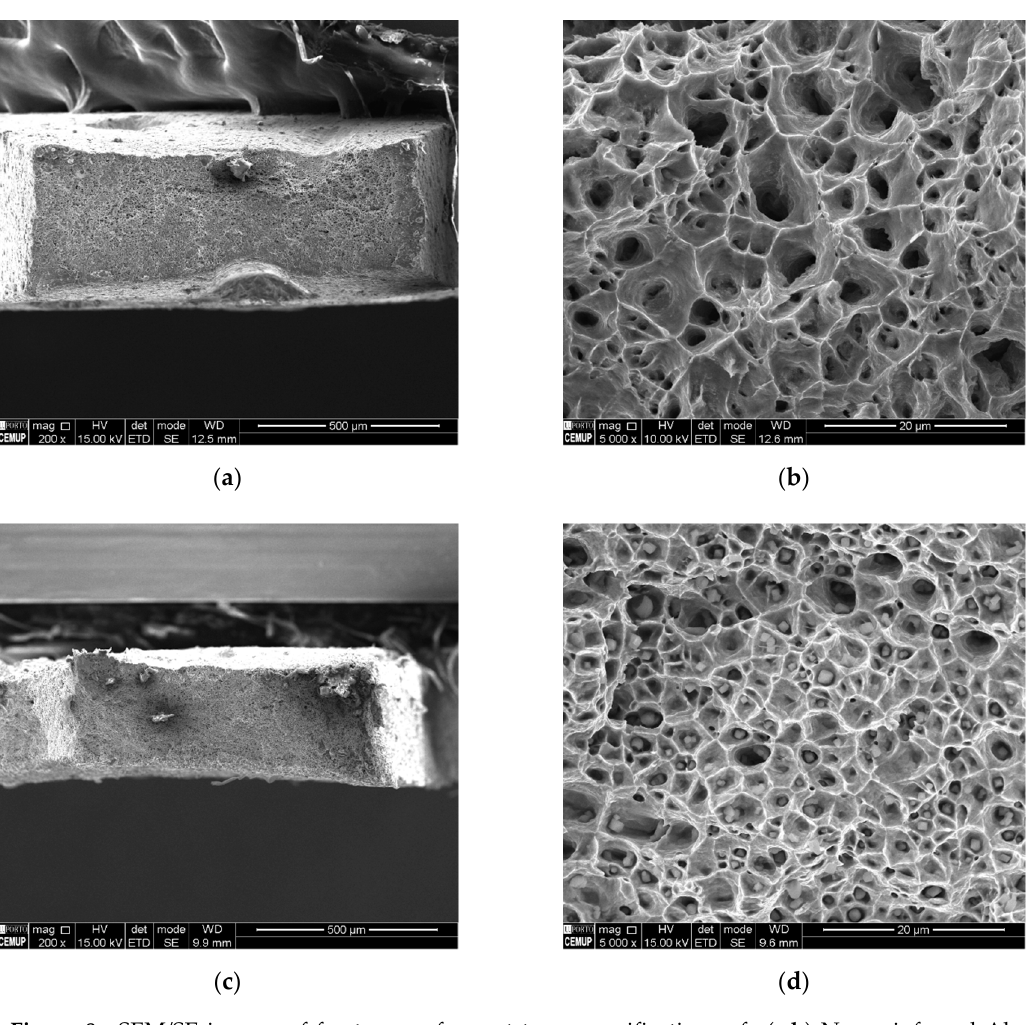
Figure 8. SEM/SE images of fracture surfaces at two magnifications of: ( a , b ) Non-reinforced Al specimen; ( c , d ) Al-WC composite.